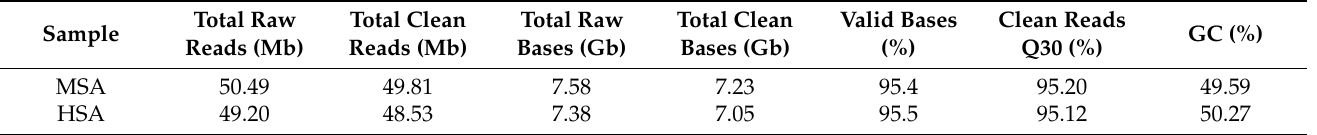
Figure 1. The growth and development of rice was inhibited under high saline–alkali (HSA) con- ditions. ( A ) The rice plants grown under mild saline–alkali (MSA) and HSA conditions. ( B ) The leaves were severed from plants at the booting stage, and were used for enzyme activity determi- nation, transcriptome, metabolome analyses, and RT-qPCR. ( C – E ) MDA content ( C ), antioxidant enzyme activities ( D ), and proline content ( E ) in rice leaves. Data are mean ± SE of three biological replicates. *, p < 0.05; **, p < 0.01; ***, p < 0.001; Student’s t-test. Abbreviations: ascorbate peroxi- dase (APX); catalase (CAT); malondialdehyde (MDA); peroxidase (POD); proline (PRO); superoxide dismutase (SOD). Table 2. RNA sequencing data